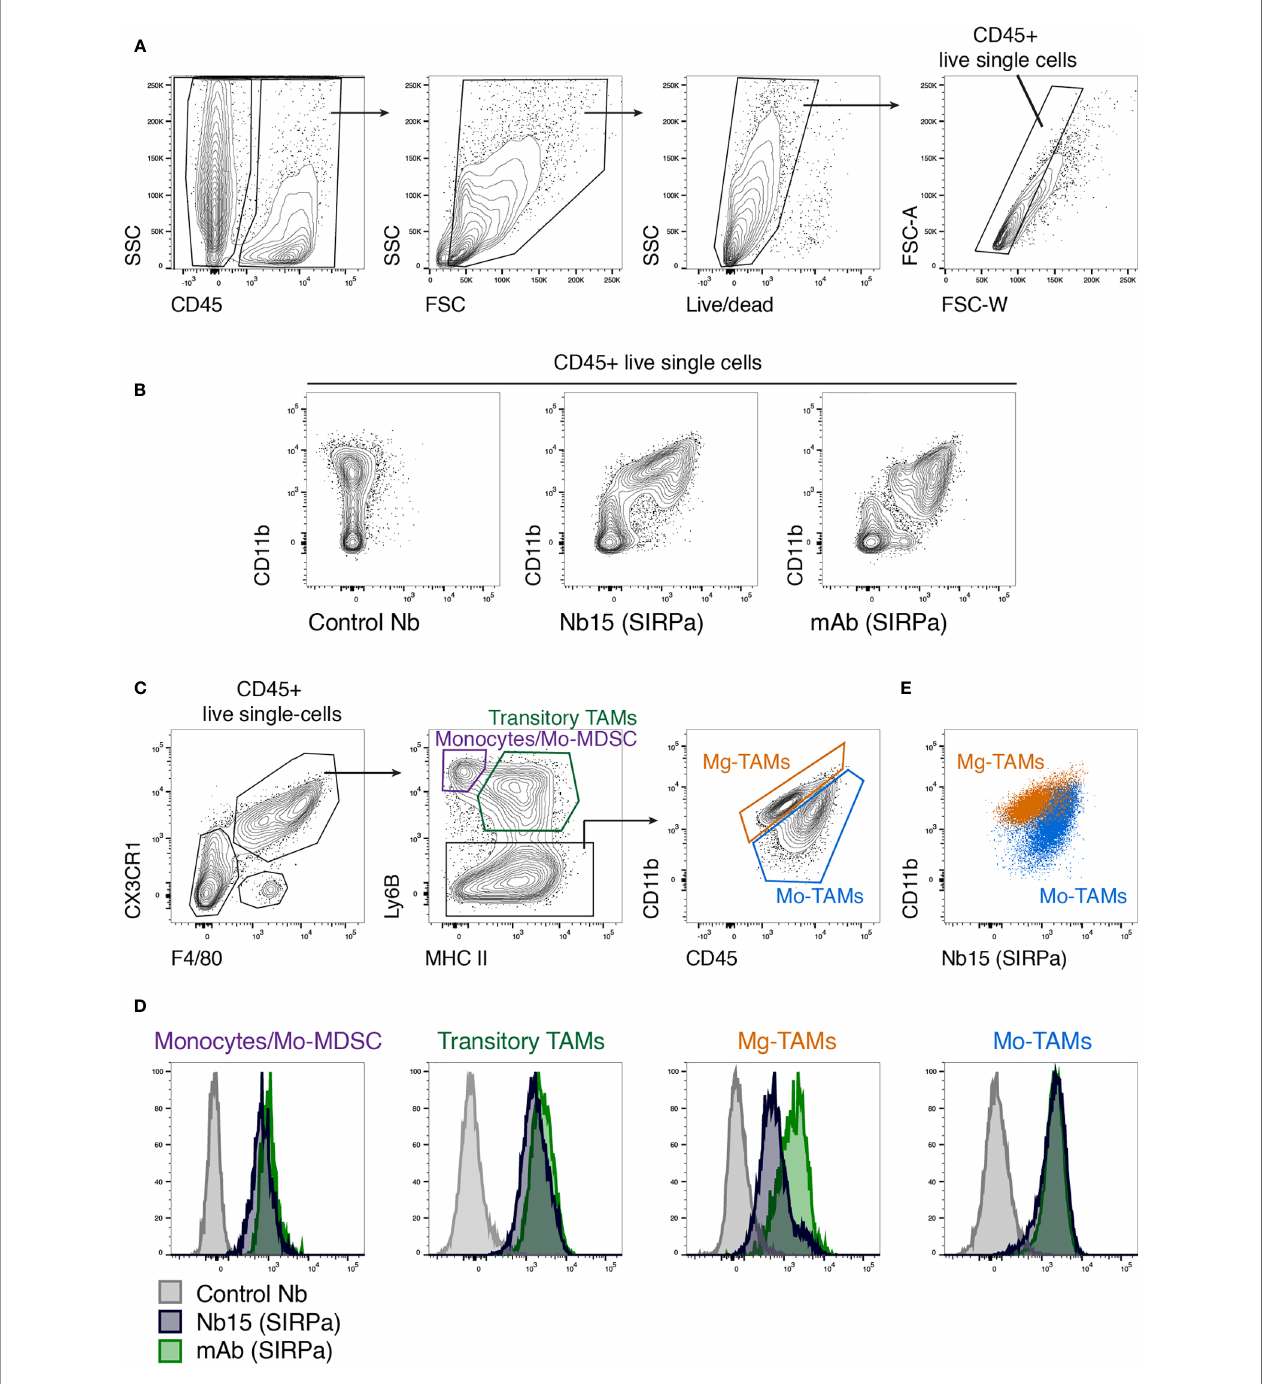
FIGURE 4 | Ex vivo staining con fi rms the speci fi city of anti-SIRP a Nb15 for tumor-associated monocytes and macrophages. (A) Single-cell suspensions were made from orthotopic GL261 tumors, followed by fl ow cytometric analysis. CD45 + live single cells were gated as indicated. (B) Flow cytometry plots showing staining with CD11b in combination with either a non-targeting control nanobody, an anti-mSIRP a Nb15 or a commercially available monoclonal anti-mSIRP a antibody. Cells were pre-gated on CD45 + live single cells. (C) Tumor-in fi ltrating monocyte and macrophage populations were gated based on their expression of CX3CR1, F4/80, Ly6B, MHC-II, CD11b and CD45, as indicated. Monocyte-derived or Mo-TAMs and microglia-derived or Mg-TAMs were distinguished based on their differential expression of CD11b versus CD45. (D) Histogram plots showing staining with a commercially available anti-mSIRP a mAb (green), anti-mSIRP a Nb15 (blue) or a non-targeting control Nb19 (grey) for the indicated populations [gated as shown in (C) ]. (E) CD11b and anti-mSIRP a Nb15 staining in Mo-TAMs (blue) and Mg-TAMs (orange) were overlaid to reveal their differential expression. Results are representative of n = 4